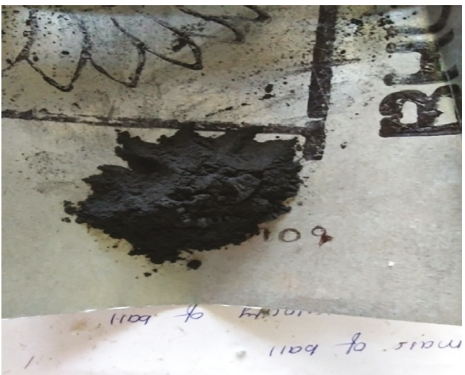
Figure 5: Graphene powder